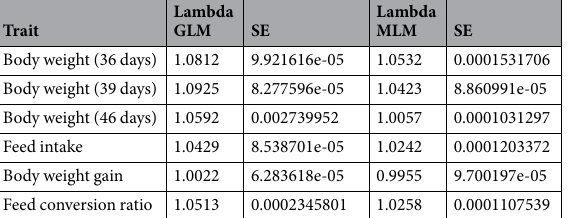
Table 3. Comparison of lambda values with standard errors in general linear model (GLM) and mixed linear model (MLM)